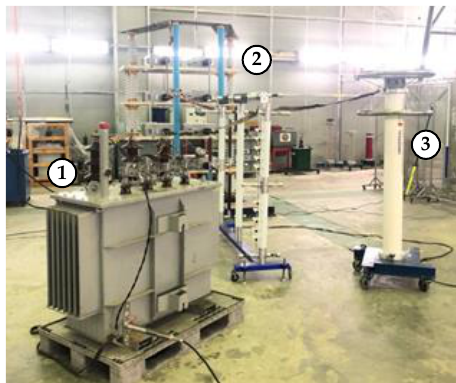
Figure 23. Experimental set up of the completed test system for the lightning impulse test of the distribution transformer winding, where (1) is the transformer under test, (2) is the impulse voltage generator, and (3) is a voltage divider. Table 7. Selected circuit parameters of the lightning impulse voltage generation circuit.